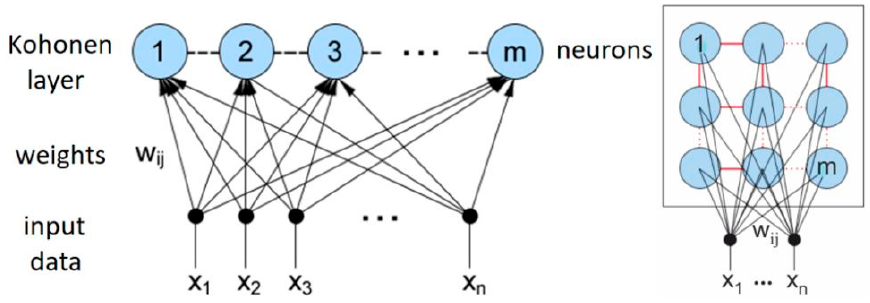
Figure 3. The structure of a Kohonen network.